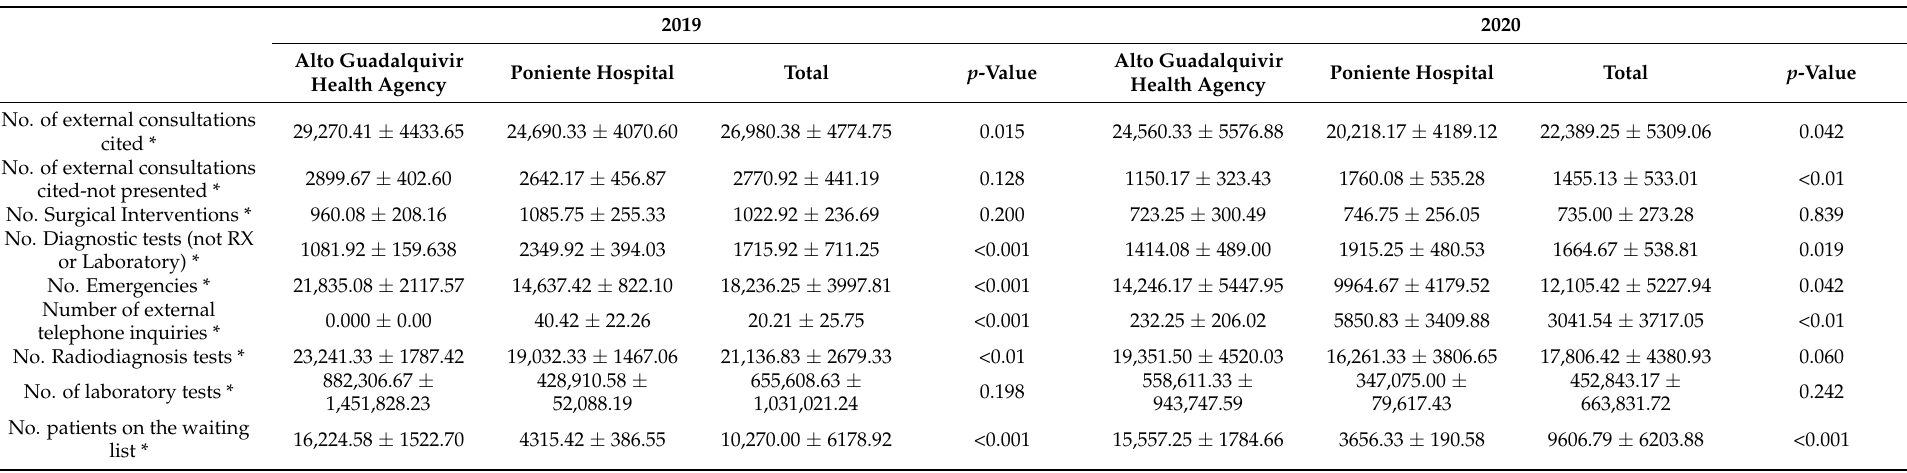
Table 3. Comparison of the parameters included in the study between Poniente Hospital and Alto Guadalquivir Health Agency during 2019 and